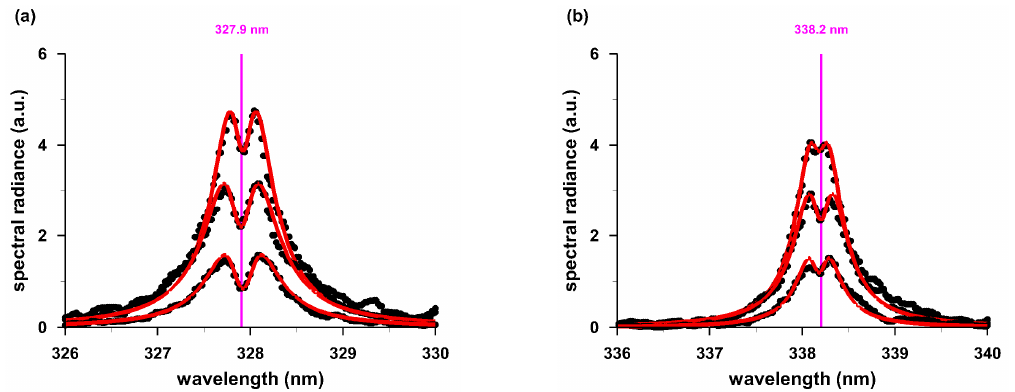
Figure 5. AgI ( a ) 327.9 nm and ( b ) 338.2 nm lines, 1064-nm excitation, fluences of 13.5, 11.5, 8, and 6 J/cm 2.